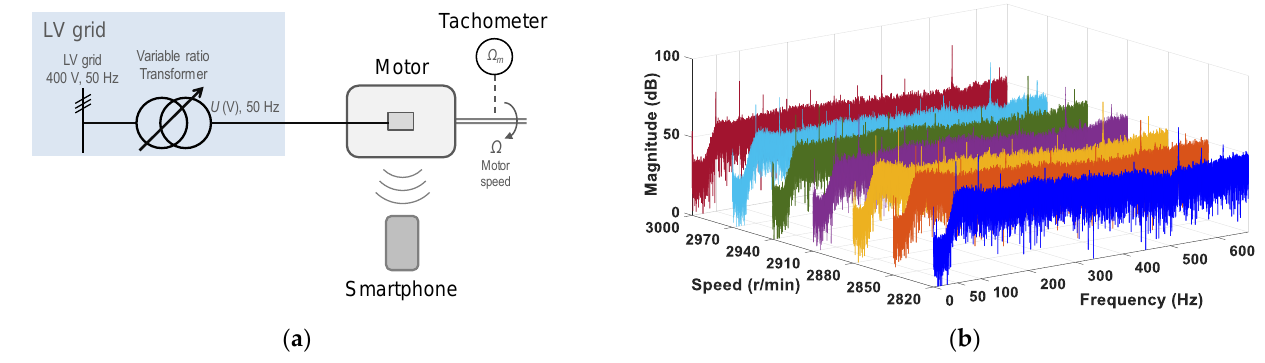
Figure 6. No load coupled to the motor shaft: ( a ) the test configuration; ( b ) the spectra of the motor noise signals. Table 3. No load coupled to the motor shaft: the rotor shaft mechanical frequency and the values of the frequencies cor- responding to the 11 peaks of the magnitude of the spectrum of the noise signal.